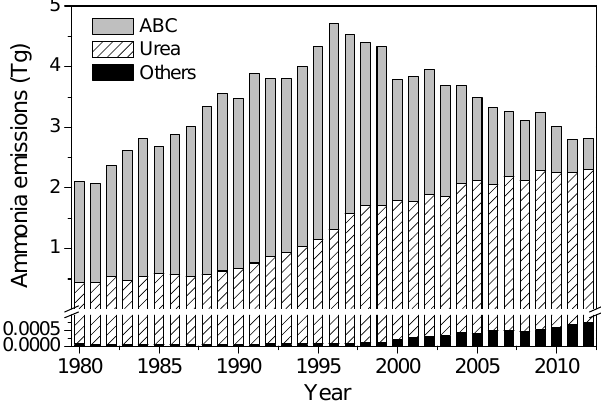
Figure 3. Interannual variation in NH 3 emissions from synthetic fertilizer in China from 1980 to 2012; types of synthetic fertilizer were categorized as urea, ABC, and others (AN, AS, and